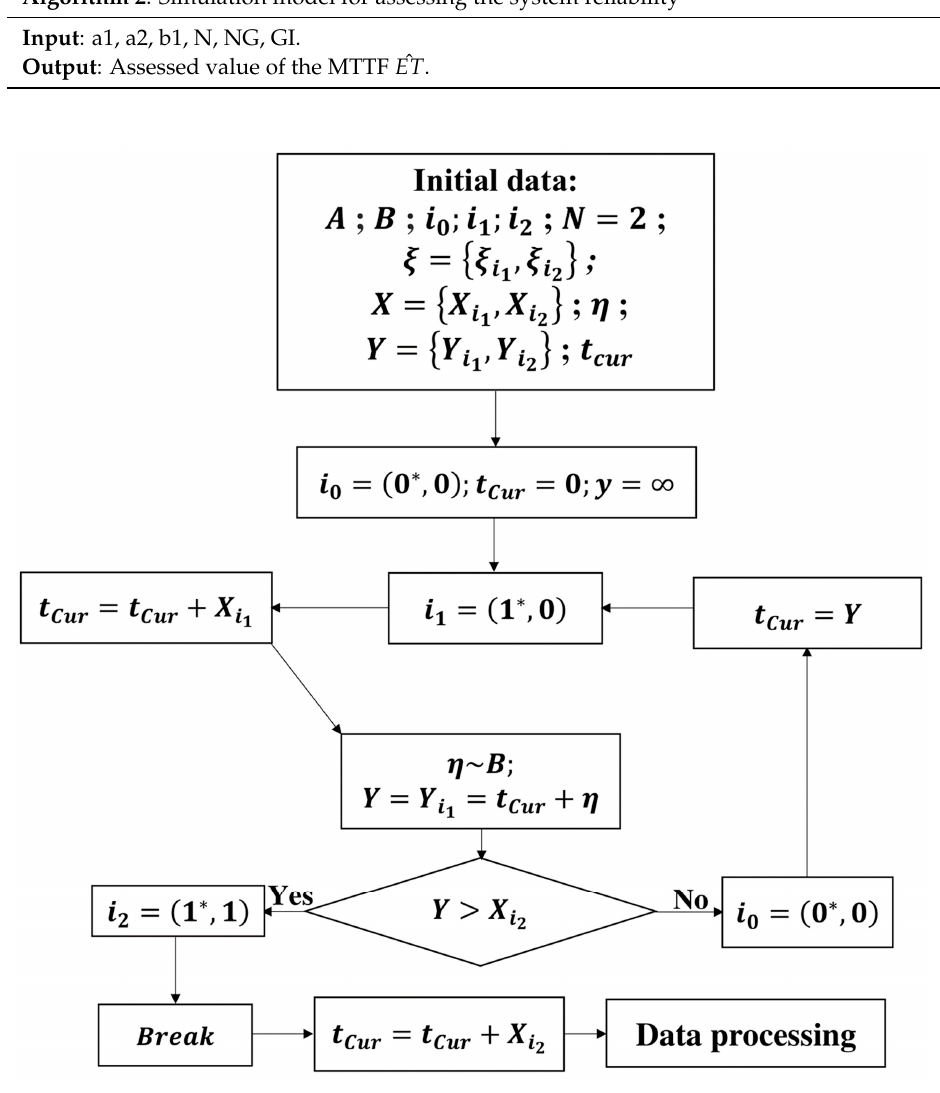
Figure 3. Block diagram of the simulation model for assessing system reliability.